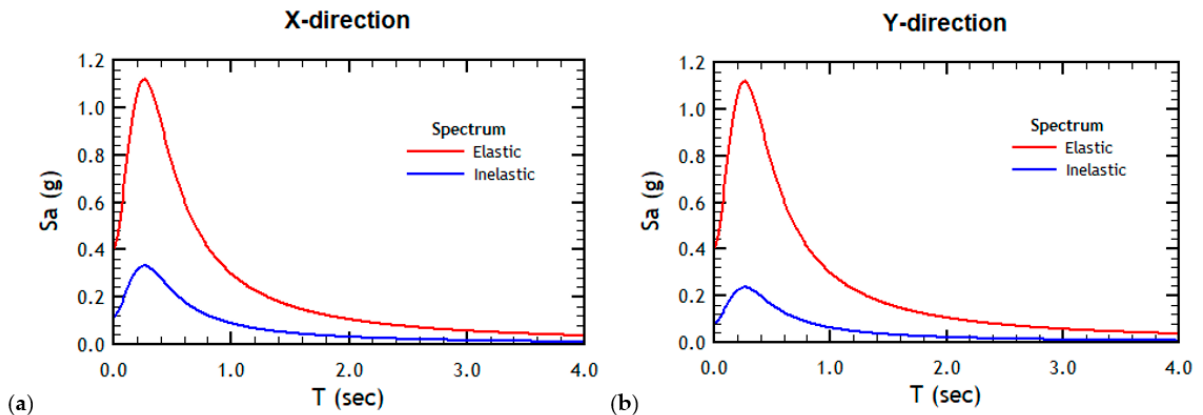
Figure 8. Chilean-code-based elastic (red) and reduced (blue) spectra relevant to Quillota (LAT − 32.881 LON − 71.244) for the ( a ) X and ( b ) Y components. Parameters used: soil factor S = 1.0; build- ing category I = 1.0; peak ground acceleration a 0 = 3.924 m/s 2 ; damping ratio ξ = 5%; fundamental periods 𝑇 (cid:2869)(cid:3051) = 0.0904 s and 𝑇 (cid:2869)(cid:3052) = 0.1694 s ; reductions factors 𝑅 (cid:3025)∗ = 3.36 and 𝑅 (cid:3026)∗ = 4.73 .